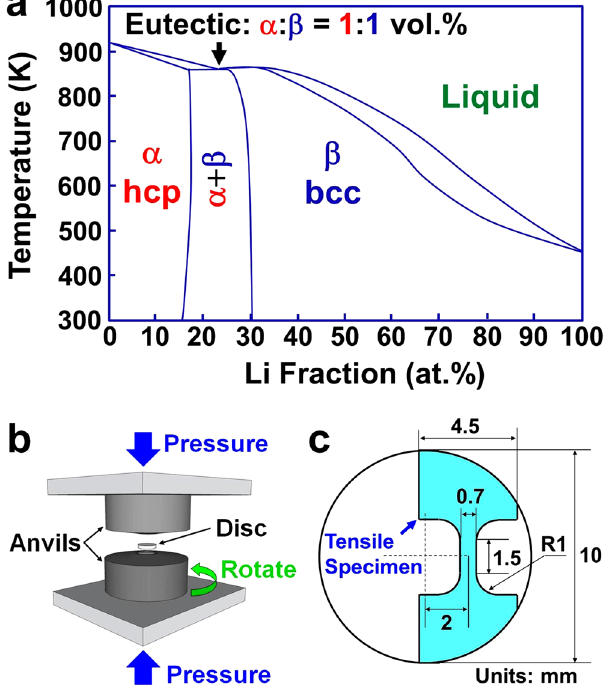
Figure 1. ( a ) Phase diagram of the Mg-Li system. The data were taken from ref. 25 to plot the phase diagram. ( b ) Schematic illustration of high-pressure torsion as an SPD method used in this study. ( c ) The procedure used to make tensile specimens from the discs processed by